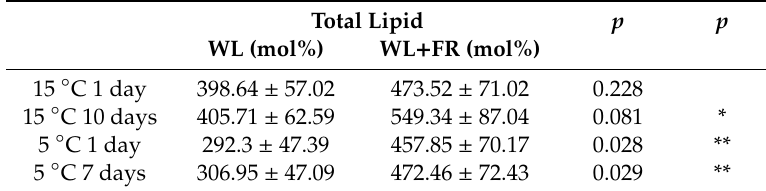
Table 1. Total lipid content in barley leaves grown at 15 ◦ C for 1 and 10 days and in leaves grown at 5 ◦ C for 1 and 7 days under WL and WL + FR.